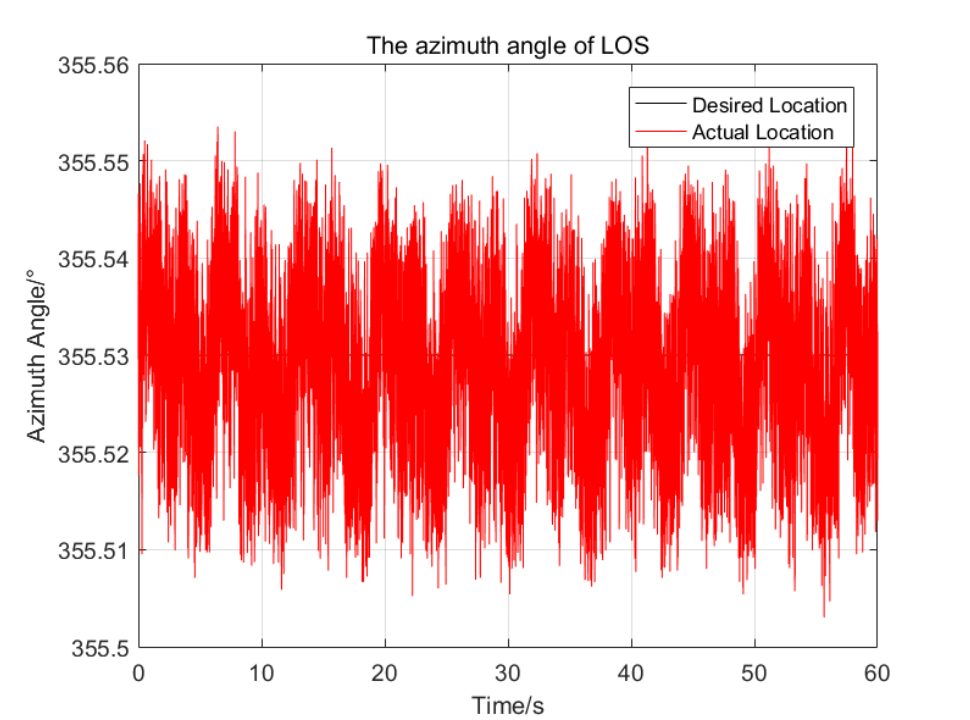
Figure 11. The experimental result of the azimuth angle generated by the proposed